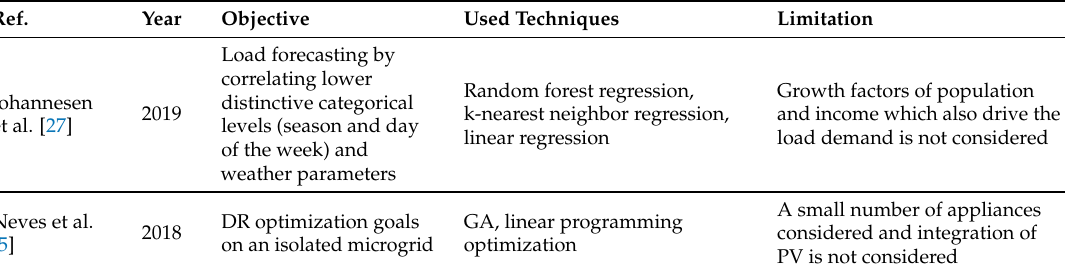
Table 1. AI techniques for distributed grid